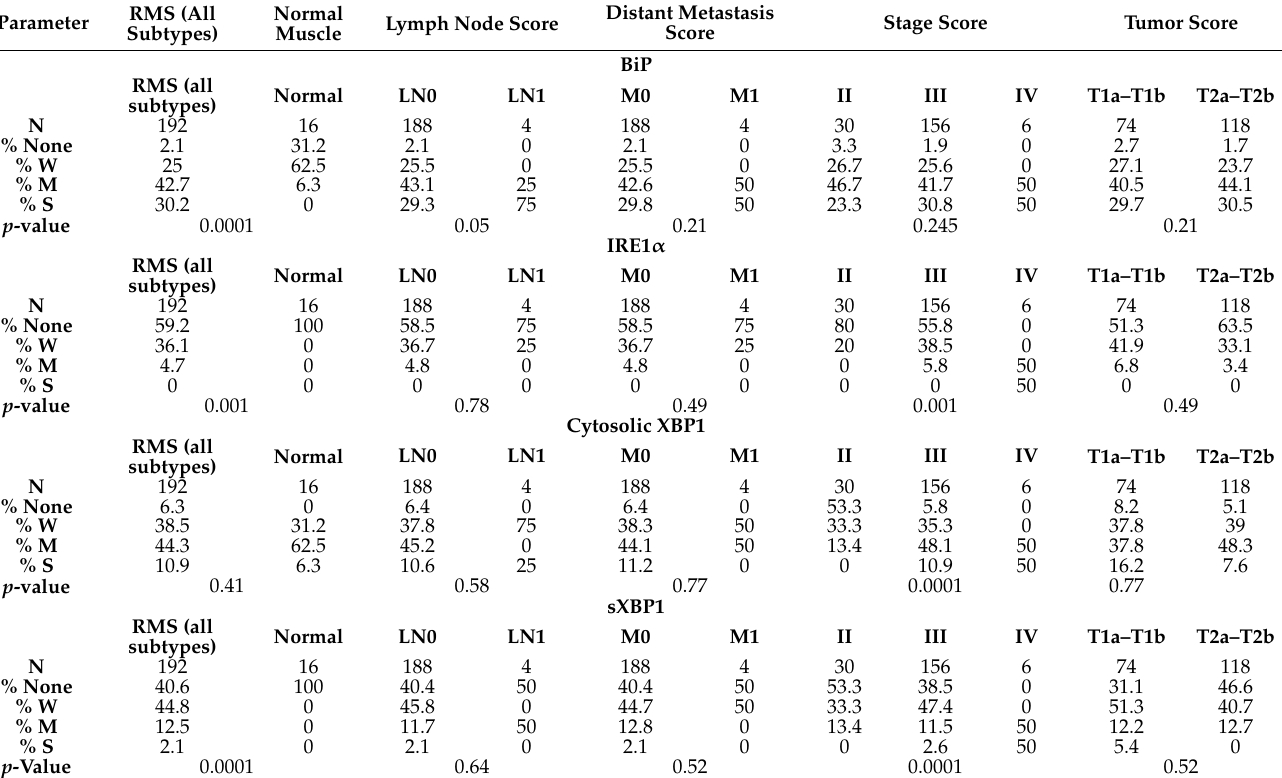
Table 1. Correlation of BiP, IRE1 α , Cytosolic and XBP1s protein expression with the clinicopathological features of RMS. Parameter